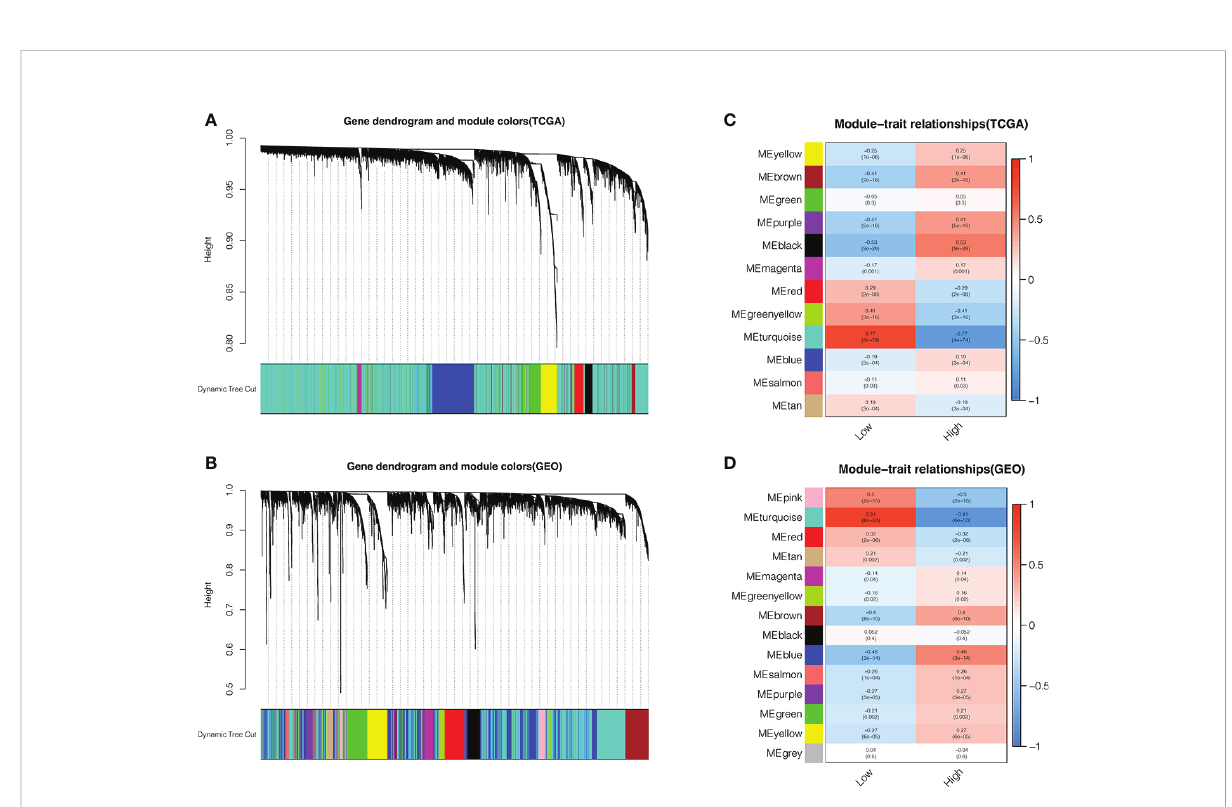
FIGURE 9 Identifying modules associated with the PYS. (A – D) Co-expression network module cluster dendrogram in TCGA-HBV-LIHC (A) and GSE14520 (B) cohorts. Module-trait relationships in TCGA-HBV-LIHC (C) and GSE14520 (D) cohort,